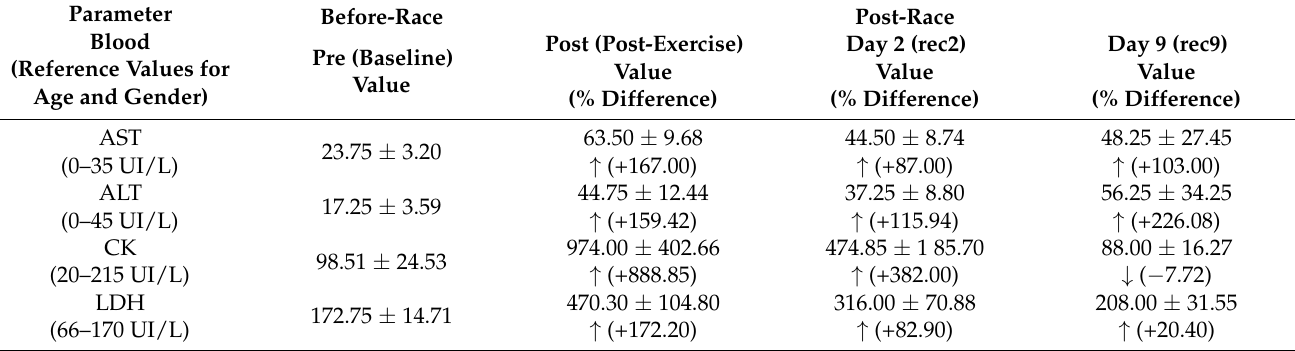
Table 3. Blood parameters before (baseline) and after race (post-exercise day 2 and post-exercise day 9).